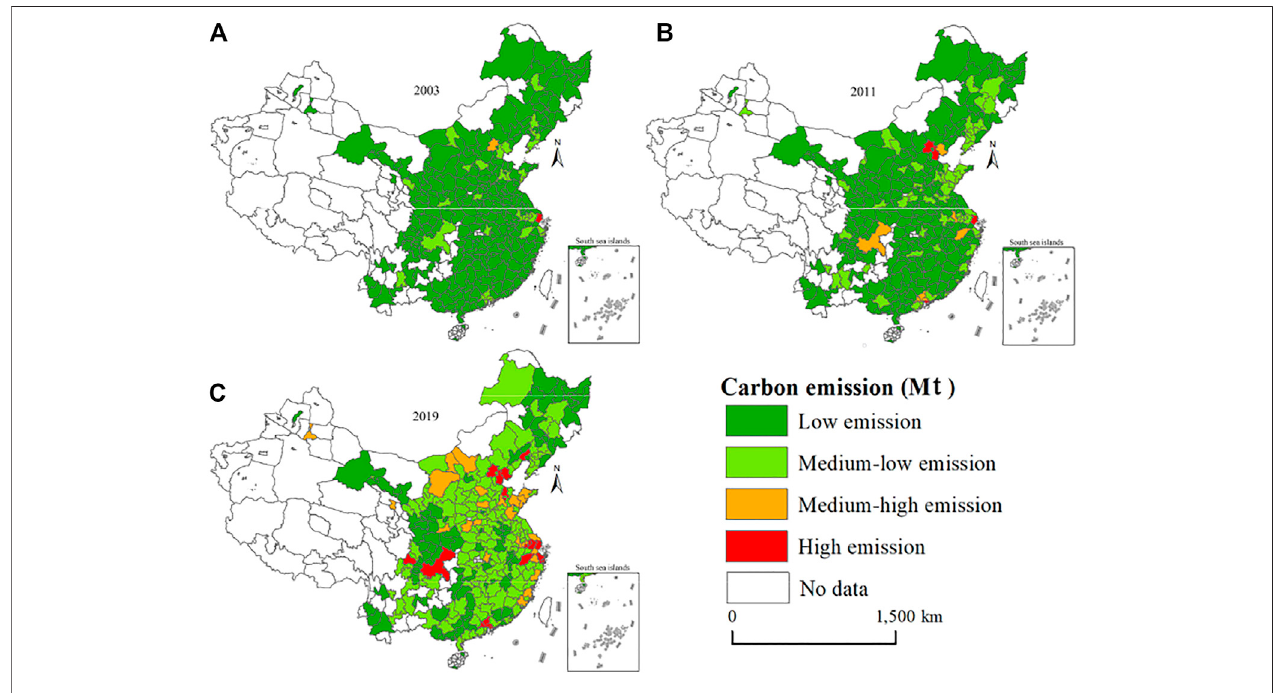
FIGURE 3 | Spatial distribution of carbon emission in 2003, 2011, and 2019.